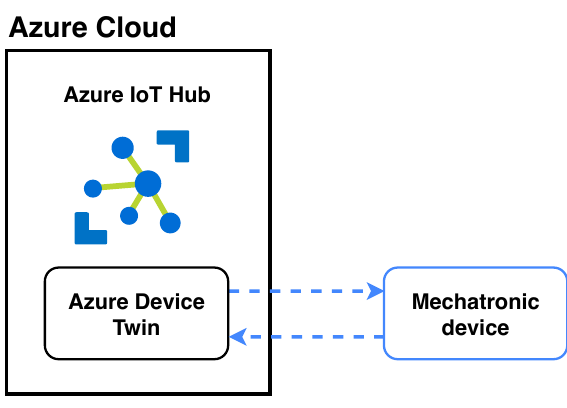
Figure 16. Device twin in Azure